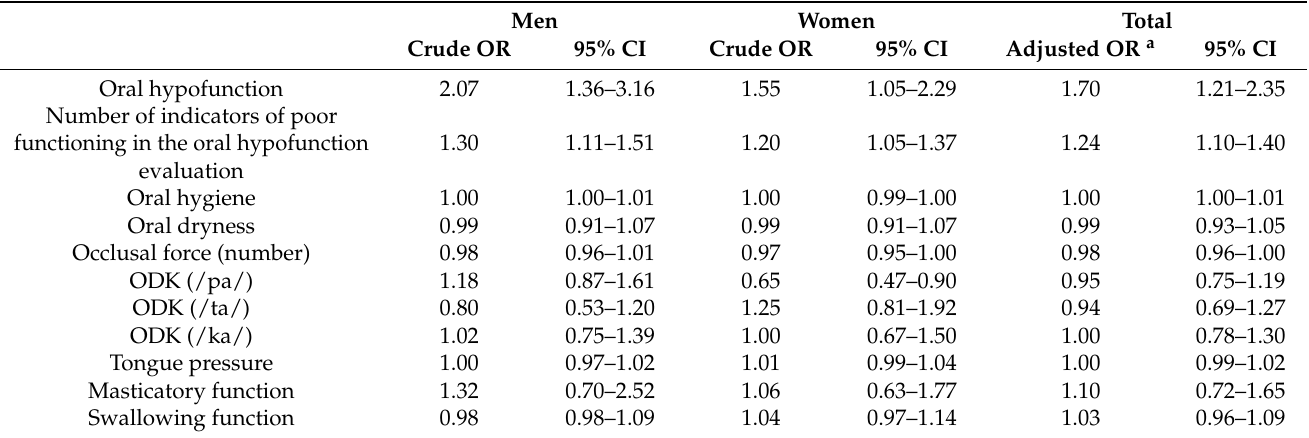
Table 6. Odds ratio for protein intake according to oral hypofunction and evaluations for oral